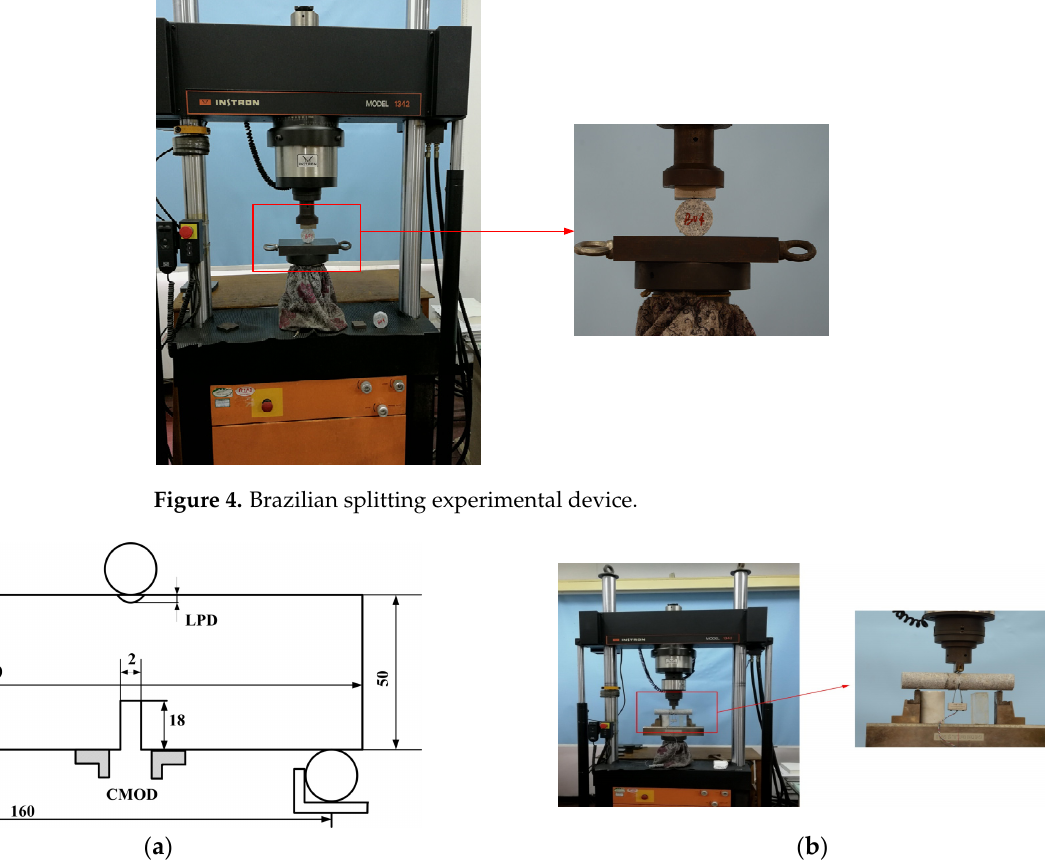
( b ) Figure 6. Stress–strain curves measured from experiments. ( a ) Uniaxial compression tests; ( b ) Bra- zilian splitting tests. Figure 7. Force–displacement curves measured from three-point bending tests.